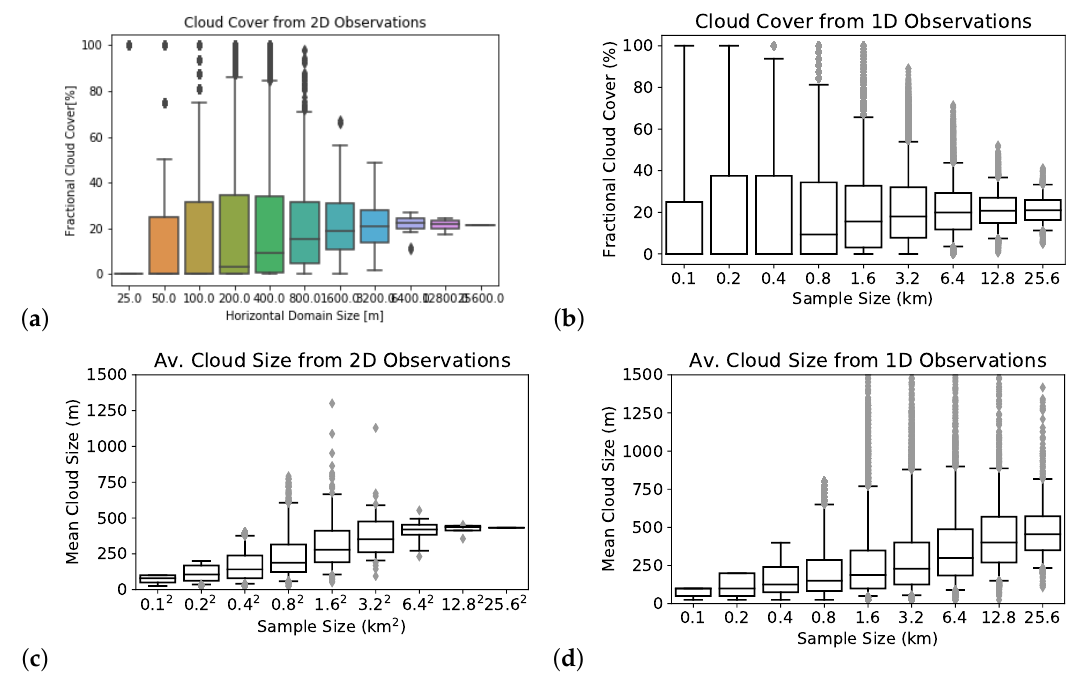
Figure 3. Box–whisker plot of the LES-retrieved fractional cloud cover and cloud size as a function of sample size: ( a , b ) cloud cover and ( c , d ) weighted average cloud size; ( a , c ) for area measurements and ( b , d ) based on chord length observations. Based on the 8th hour of RICO. Fifty percent of the measurements falls within the box, and 95% of the measurements within the whiskers. The line within the box gives the median